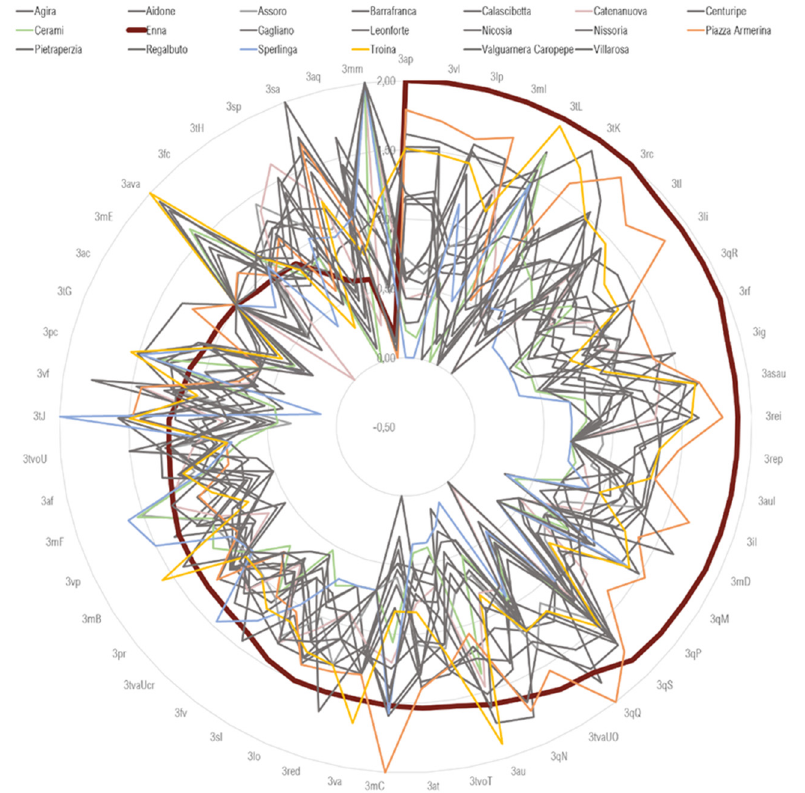
Figure 15. Representation of the structured comparisons between the performances of each of the twenty municipalities.